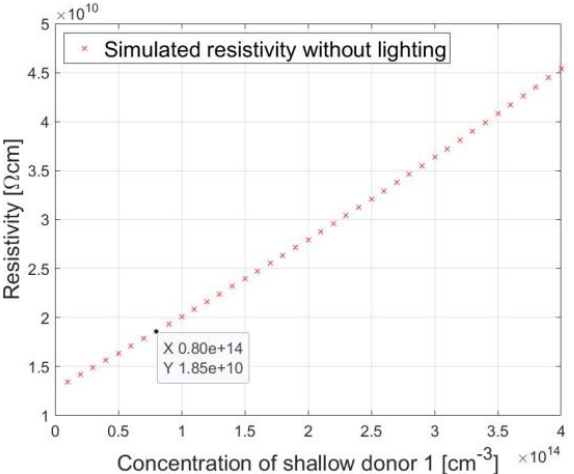
Figure 2. Simulation of the dependence of the resistivity of an unlit material on the concentration of the defect SD1, SD2, DD, DA, and SA defect concentration equal to 1.3 × 10 14 , 3.4 × 10 14 , 3.3 × 10 15 , and 2.8 × 10 14 cm − 3 , respectively. Simulations carried out at the temperature of 300 K.